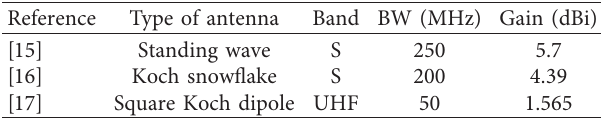
Table 1: Comparison of some outstanding fractal antennas for CubeSats.